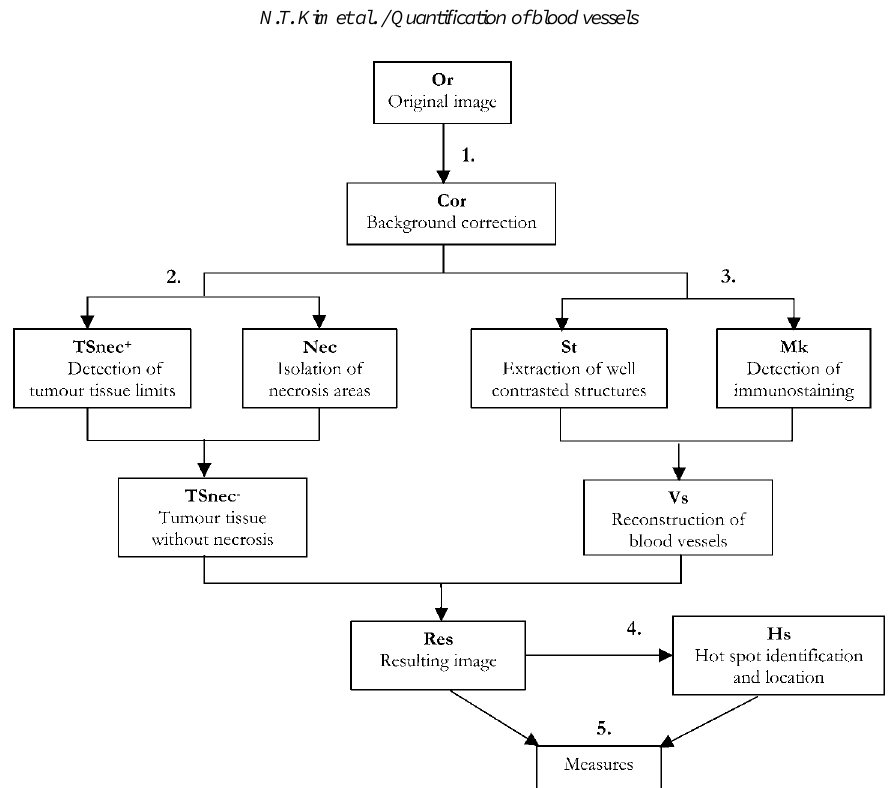
Fig. 1. Strategy for automatic microvessel isolation. The procedure was divided into 5 steps: background correction (1), detection of tumour tissue limits (2), isolation of vessel (3), identification and location of hot spots (4) and measures (5).